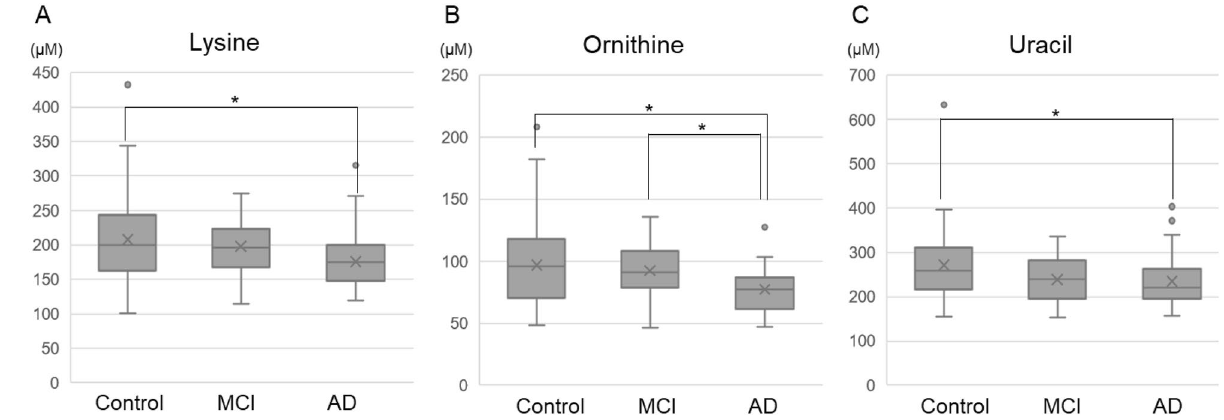
Figure 1. Comparisons of mean plasma amino acid values for ( A ) lysine, ( B ) ornithine, and ( C ) uracil. * P <